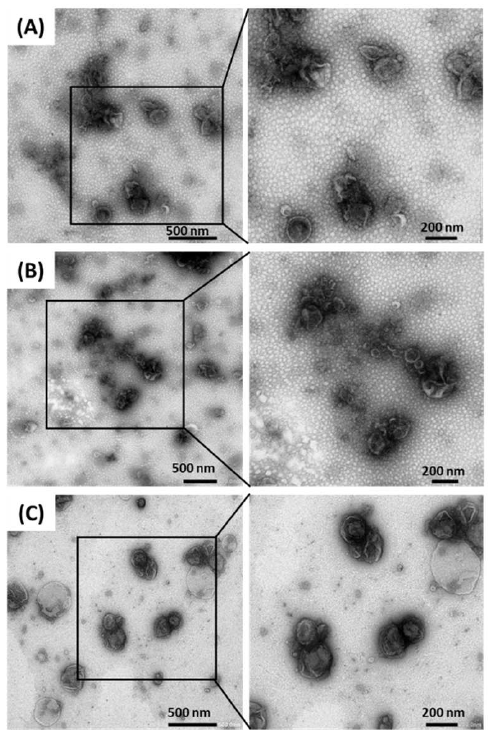
Figure 4. Transmission electron microscopy (TEM) imaging of isolated MBVs derived from decellularized porcine SIS ( A ), UBM ( B ), and liver ( C ).